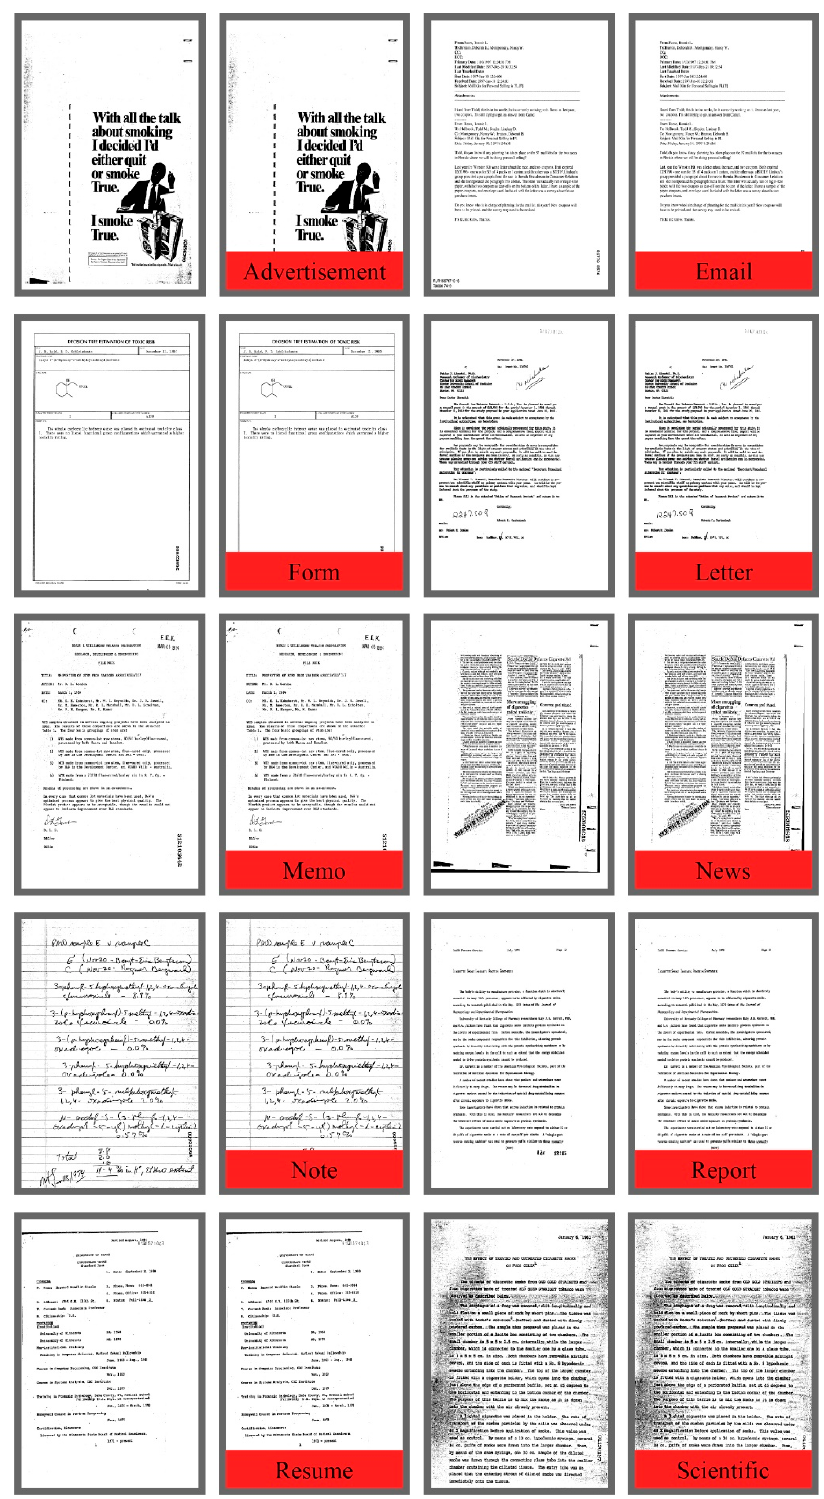
Figure 5. Labeled outputs of the proposed technique.